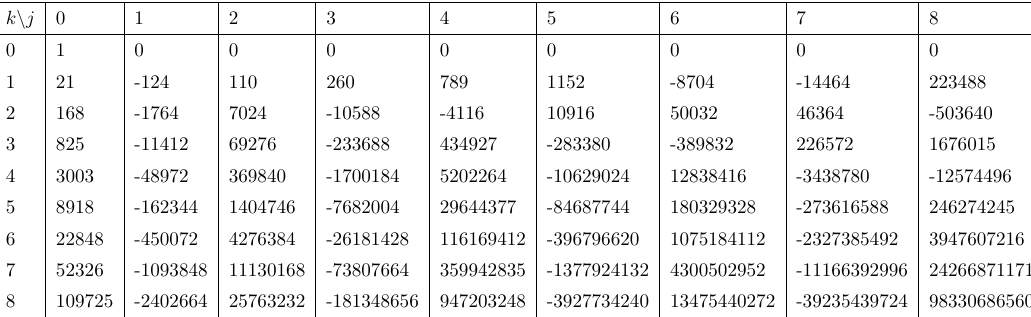
Table 42. Table of b jk coe(cid:14)cients for h SO(7)